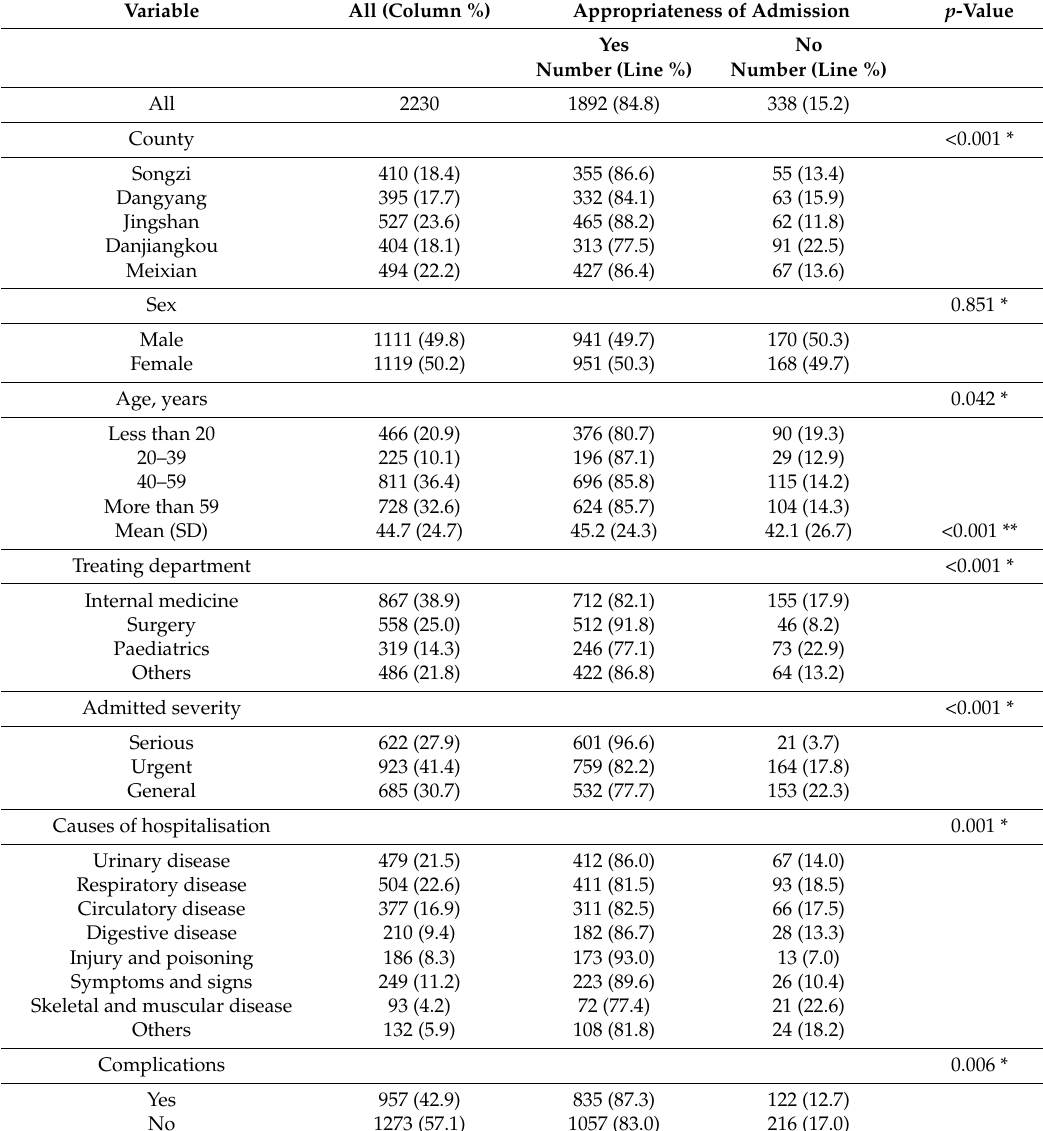
Table 2. Distribution of cases and appropriateness of admission ( n =